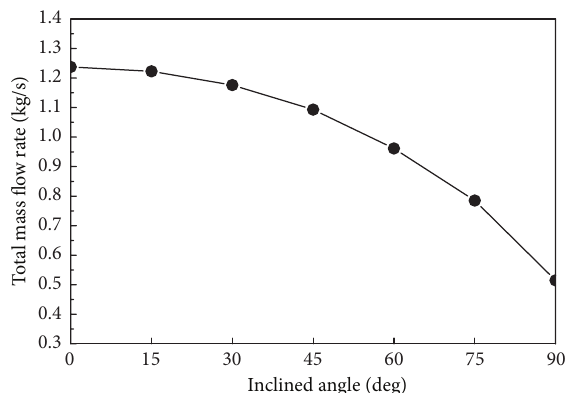
Figure 8: Total mass flow rate variation with inclined angle.